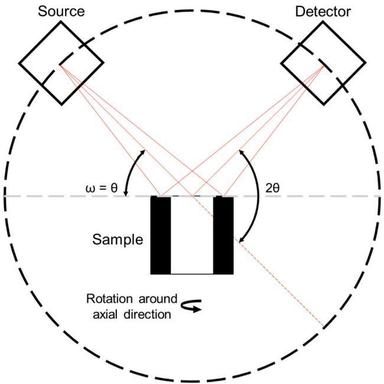
Set-up of the XRD of the cut cross-section of post testing quenched samples.